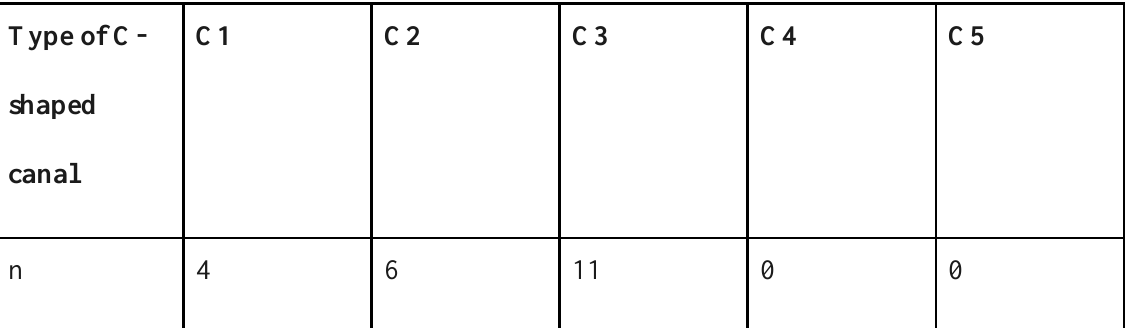
Prevalence of par�cular types of C - shaped canals in mandibular second molars